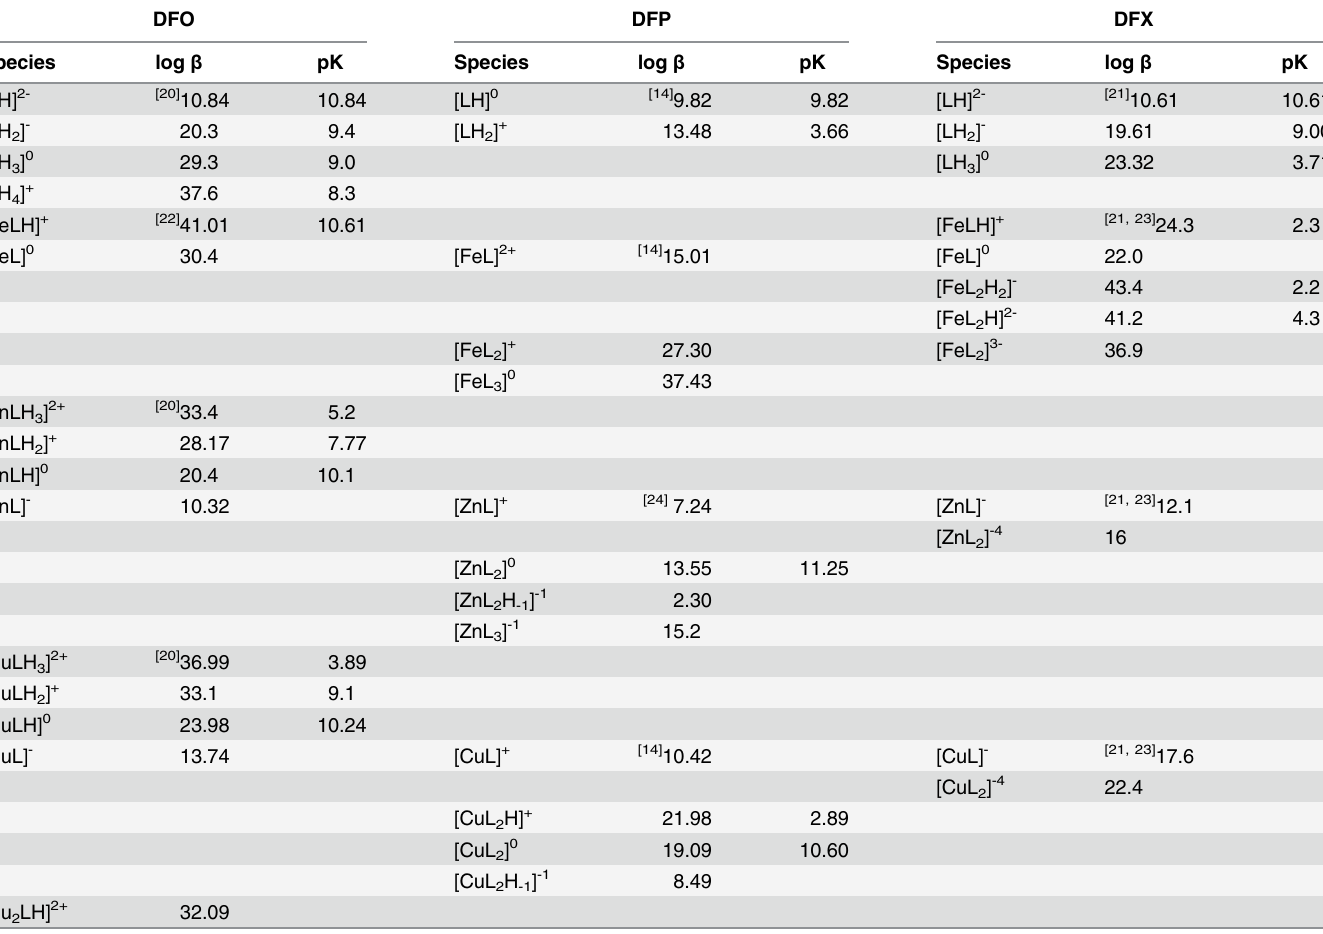
Table 1. Protonation and complex formation constants for DFO, DFP and DFX with iron(III), copper(II) and zinc(II) from literature. DFO DFP DFX Species log β pK Species log β pK